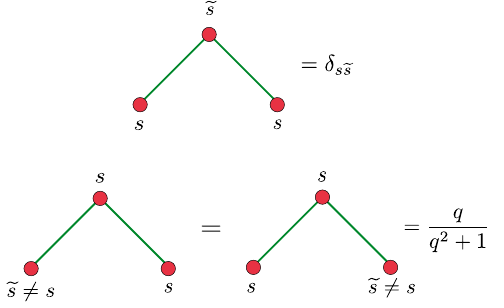
¯ F . The FIG. 15. Weights for the three-body interaction that arises after l 1 . integrating out half of the Ising variables (the bra u ¼ v ¼